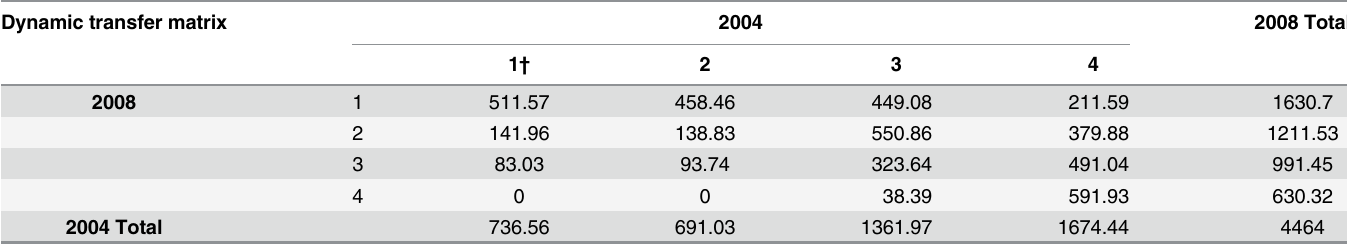
Table 3. Transfer matrix of soil erosion of the ecological restoration area during 2004 – 2008 (km 2 ).